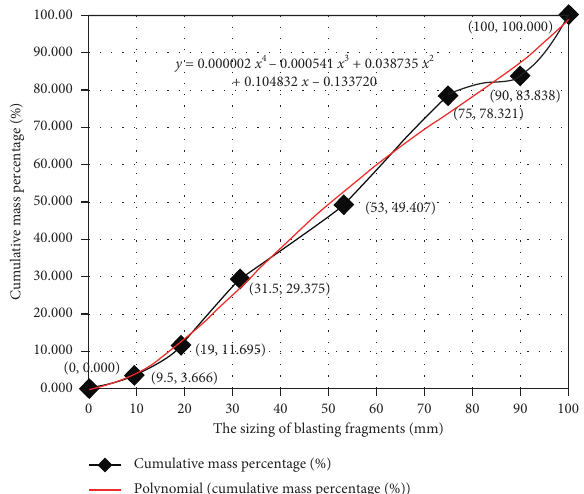
Figure 14: Relationship between cumulative mass percentage of blasting fragments and fragment size particle diameter of 65 ° wedge cutting.